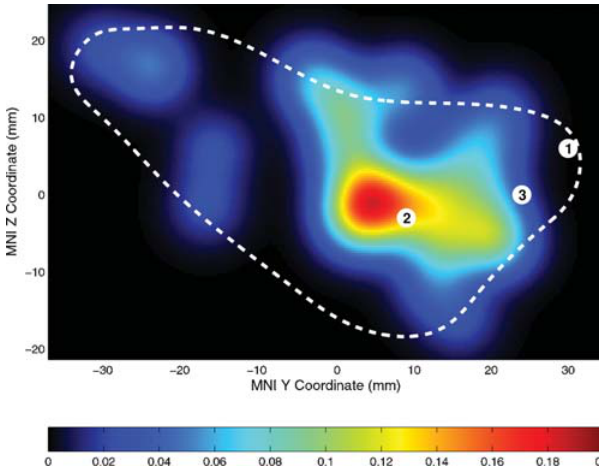
Figure 4. Relation of response peaks to the insular cortex sensorimotor hand area. The likely position of the hand area of the insular cortex was determined by a meta-analysis or previous fMRI studies [16–35]. Activation likelihood estimates (ALEs, see Methods section for further details) are color coded. The highest likelihood for hand movement-related activation was in a region from approx. Y=0 to Y=20 and from Z= 2 10 to Z=10. The peak locations of the present study are indicated by white discs; numbers refer to the rows of Tab. 1. Peak 2 was located in the region with high ALE. The dashed line indicates the approximate outline of the left